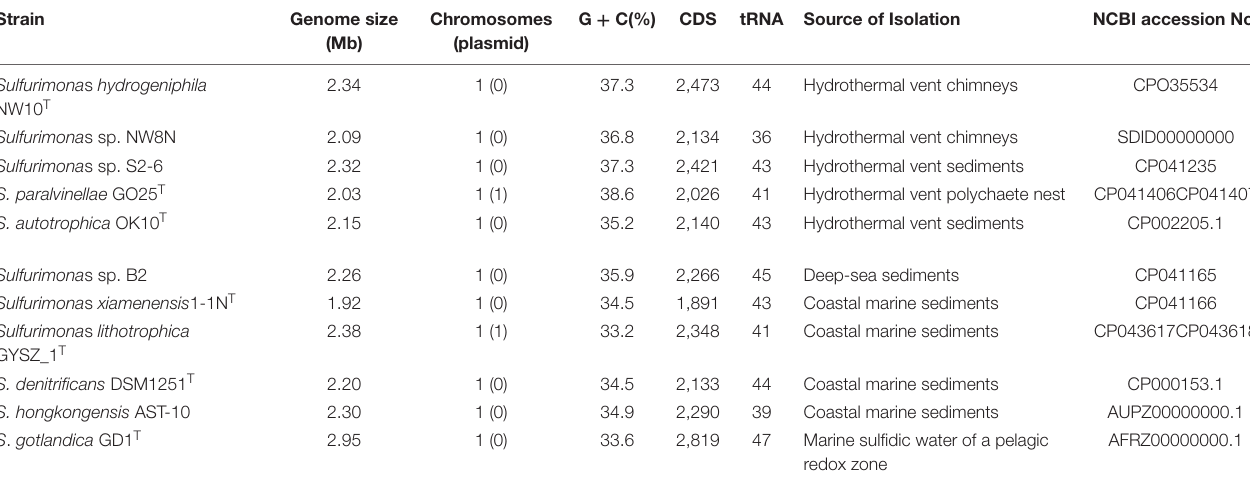
TABLE 2 | General genome features of Sulfurimonas species used in this study. Strain Genome size